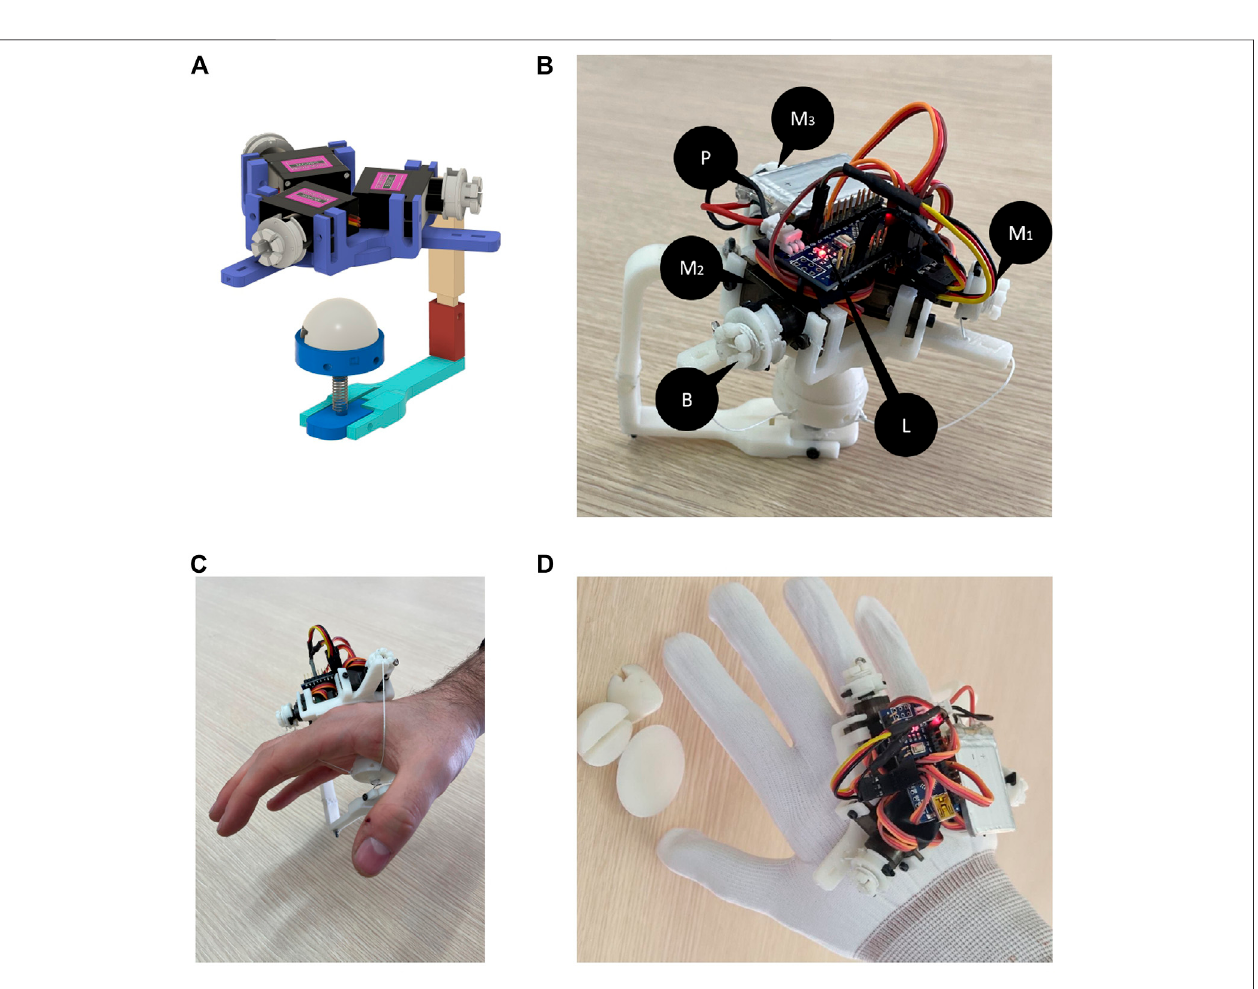
FIGURE 8 | Prototype of the device presented in this study. Sub fi gure (A) shows the fi nal CAD model of prototype, while (B) shows the device hardware components. Sub fi gure (C) report the “ naked ” device worn by a user. Sub fi gure (D) shows the fi nal prototype worn by the user together with the different modules.